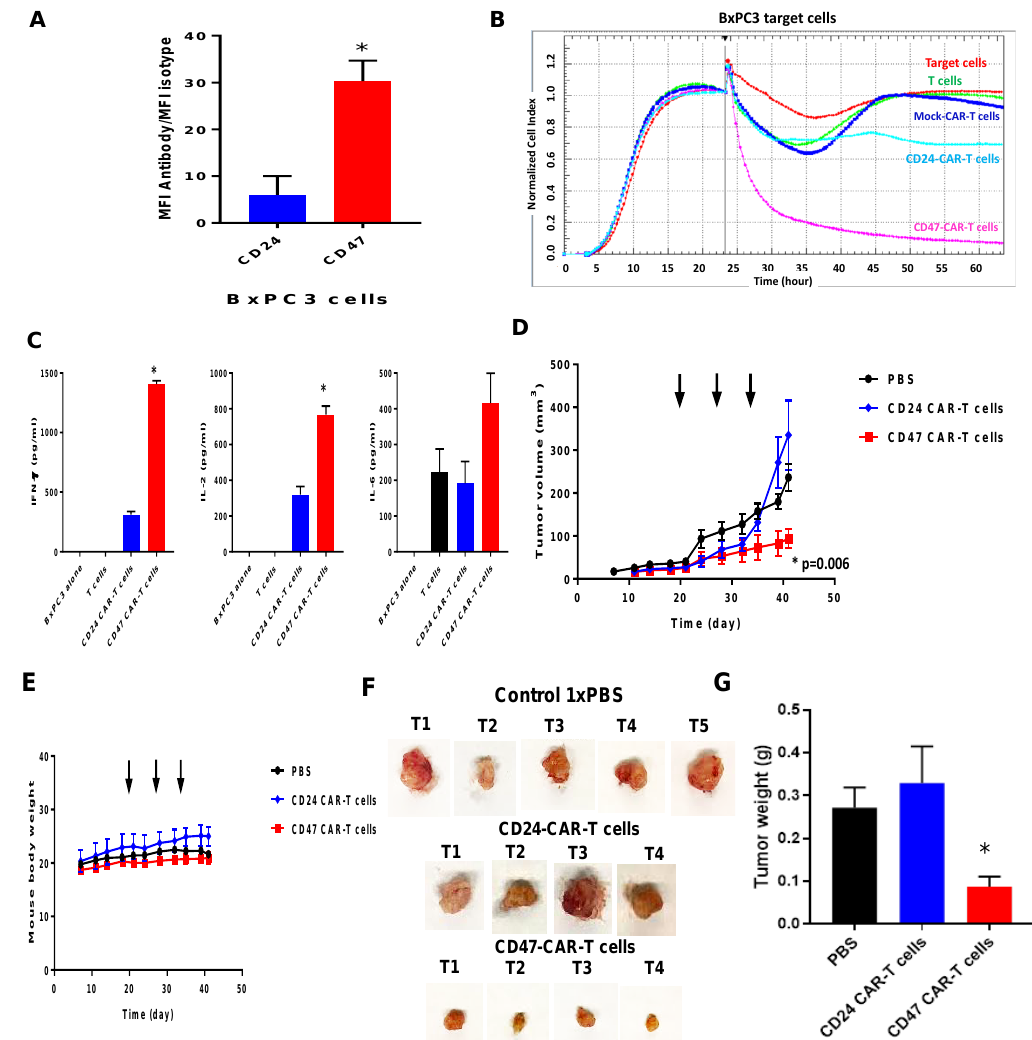
Figure 3. CD47-CAR-T cells significantly decrease BxPC3 pancreatic cancer xenograft tumor growth. ( A ) CD47 expression is significantly higher than CD24 expression in BxPC3 pancreatic cancer cells. The bars show average ratio of MFI to isotype control IgG1 of CD24 and CD47 expression in BxPC3 cells ± standard errors from two independent experiments. * p = 0.029 CD47 versus CD24, Student’s t -test; ( B ) CD47-CAR-T cells effectively killed BxPC3 cancer cell lines by RTCA assay. The control CD24-CAR-T cells and Mock Control CAR-T cells did not significantly kill BxPC3 cancer cells in three independent experiments. The CD47-CAR-T cell cytotoxicity was significantly higher than control cells in BxPC3 cells, p < 0.05, Student’s t -test; ( C ) CD47-CAR-T cells secreted high levels of cytokines: IFN-gamma, IL-2 and IL-6 against BxPC3 cells in vitro that was consistent with high cytotoxic activity of CD47-CAR-T cells against BxPCR3 cells shown in Figure 3B. The supernatants from RTCA assay were used for cytokine ILISA assay. E:T=10:1. The IL-2 and IFN-gamma cytokine levels were significantly higher in CD47-CAR-T cell samples versus control CD24-CAR-T cells, p < 0.05, Student’s t -test; ( D ) CD47-CAR-T cells significantly decreased BxPC3 tumor growth, * p = 0.006, CD47-CAR-T cells versus 1xPBS control. n = 4–5 mice, CD47/CD24-CAR-T cells and 1xPBS groups, respectively; ( E ) CAR-T cells did not affect mice weight in CD47-CAR-T cell, CD24-CAR-T cell and 1xPBS control groups. Mice weight was measured in grams two times a week; ( F , G ) CD47 CAR-T cells significantly decreased tumor size and weight, respectively. p < 0.05, CD47-CAR-T cells versus control CD24-CAR-T cells and 1xPBS groups, Student’s t -test. At the end of the experiment mouse tumors were analyzed by imaging ( F ) and measuring weight in grams ( G ).